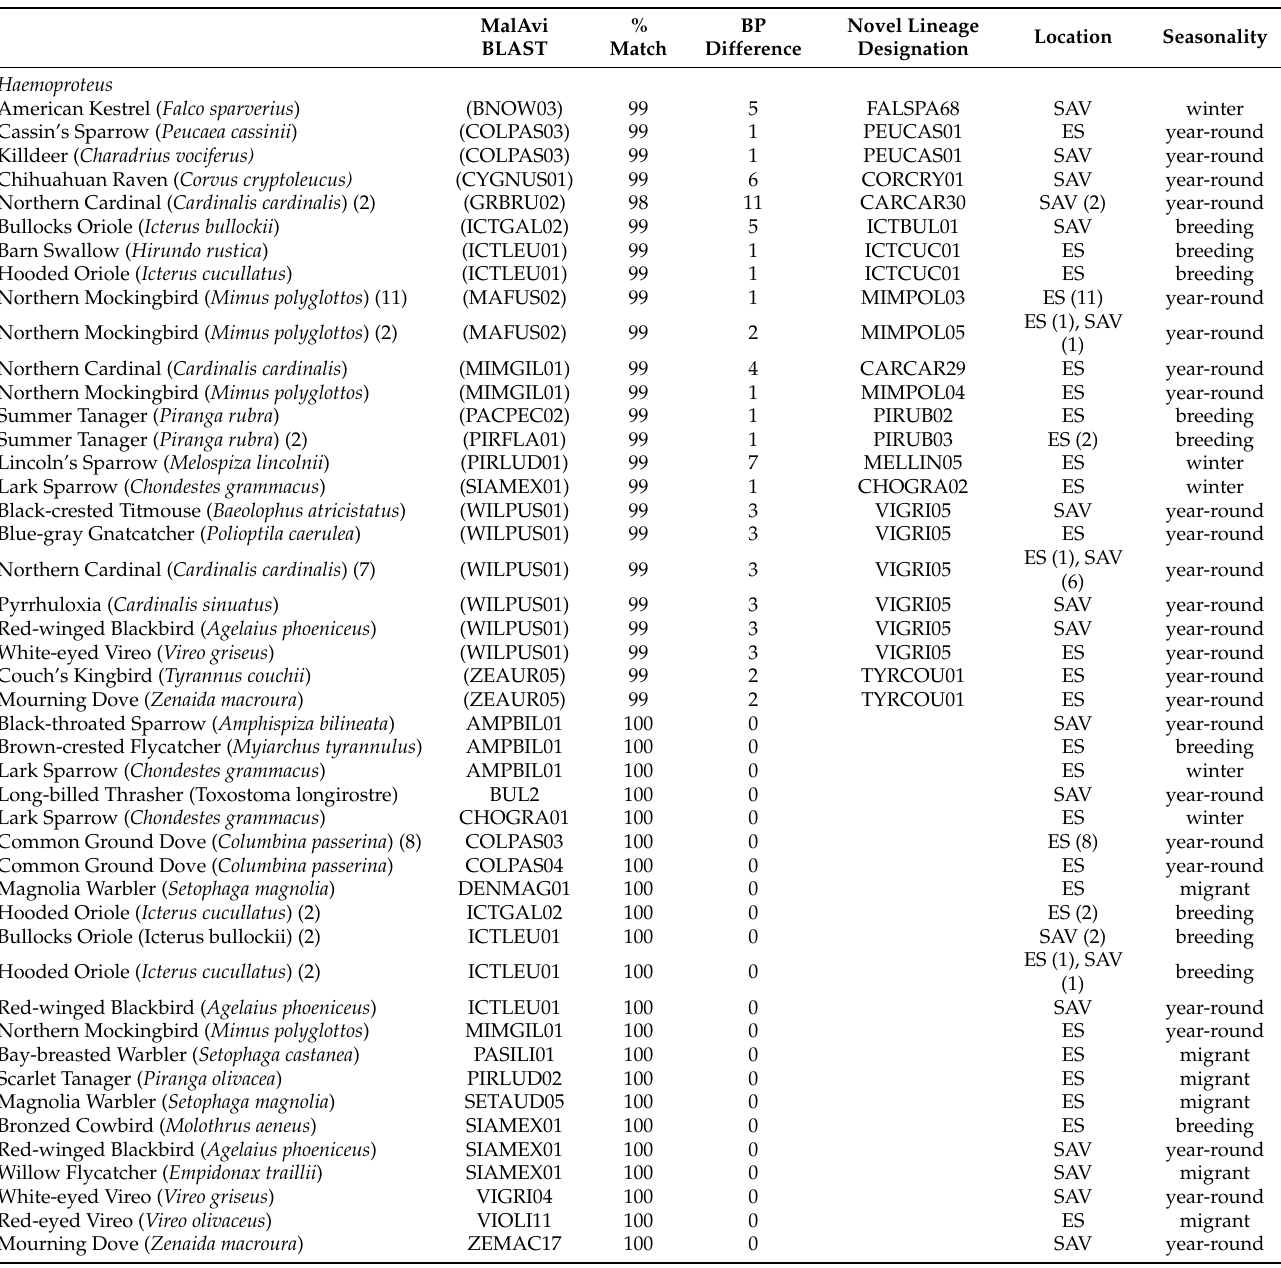
Table 6. Haemosporidian lineages recovered in our analyses, relative to avian host and sampling location; multiple individuals of a given host species are indicated in parentheses after the taxon name. Lineages were blasted to the MalAvi database. We provide in parentheses the nearest blasted lineage result in column 2 (MalAvi Blast). Lineages in this same column and without parentheses are 100% matches of those lineages to existing MalAvi lineages. If determined to be different via % match and base pair (BP) differences, we provide a novel lineage designation (column 6). Location refers to El Sauz (ES) and San Antonio Viejo (SAV) ranches, and numbers in parentheses (if present), indicate the number of individuals found on both ranches. Seasonality labels denote whether a species is present year-round, in winter, during breeding, or only along their migratory pathway. MalAvi % BLAST